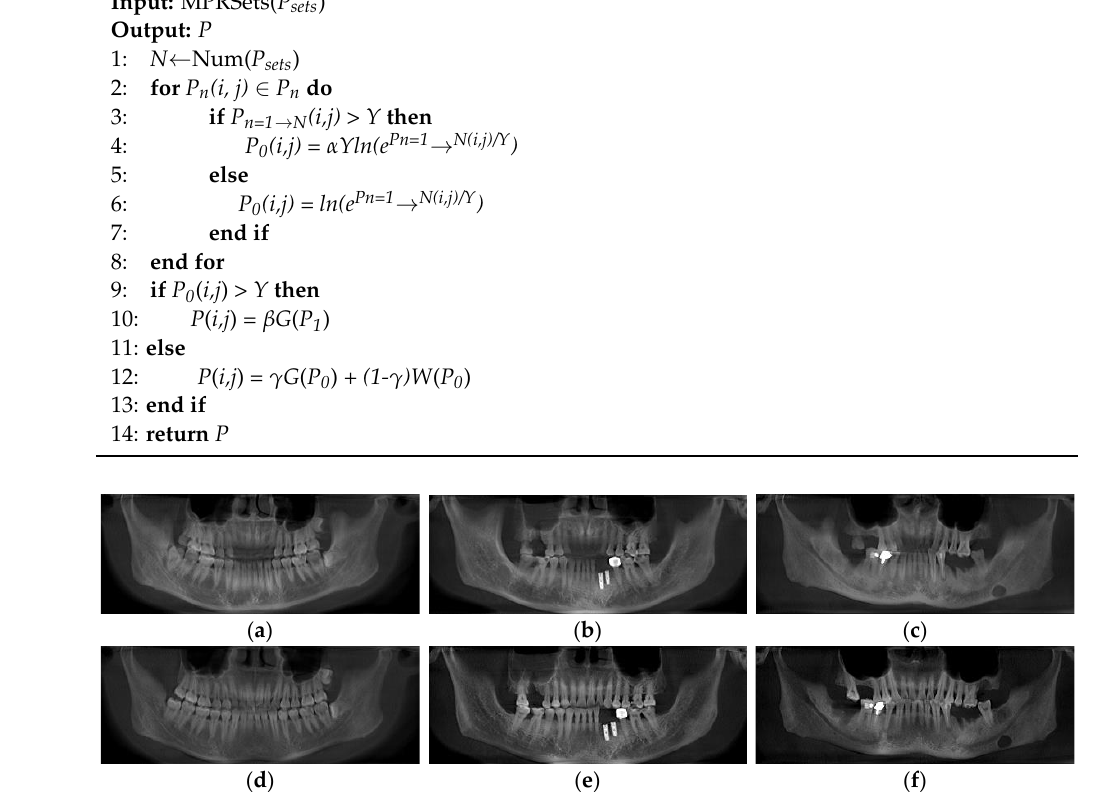
Figure 6. Dental arch detection effect diagram. ( a – c ) Panoramic image reconstructed based on the dental arch curve generated by software. ( d – f ) Panoramic image reconstructed based on the dental arch curve generated by our method.